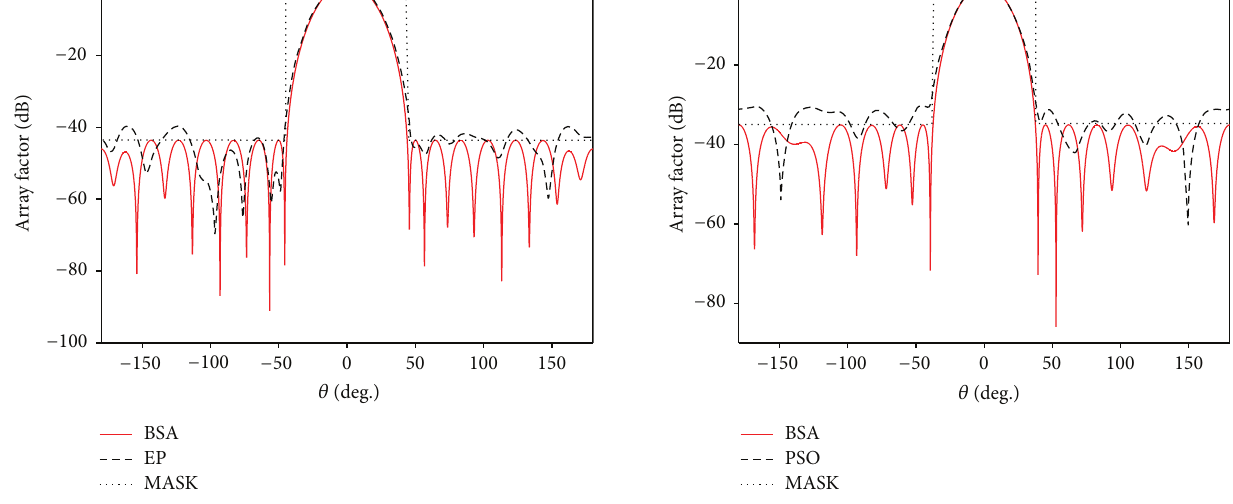
Figure 15: The radiation patterns obtained by BSA and PSO [1] for CCAA with central element.